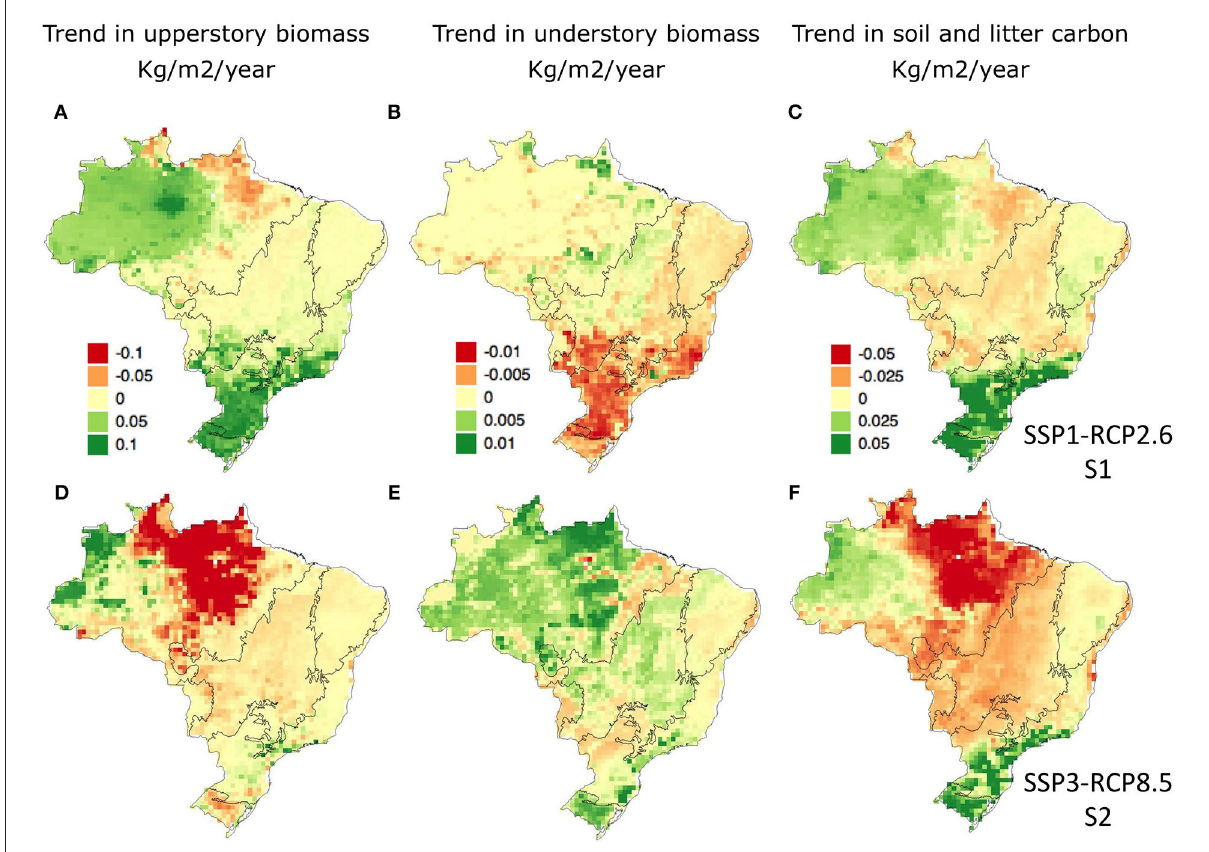
FIGURE7 Trend coefficient in the carbon pools (kgC/m 2 /year) for (A) S1 upperstory, (B) S1 understory, (C) S1 soil plus litter, (D) S2 upperstory, (E) S2 understory, and (F) S2 soil plus